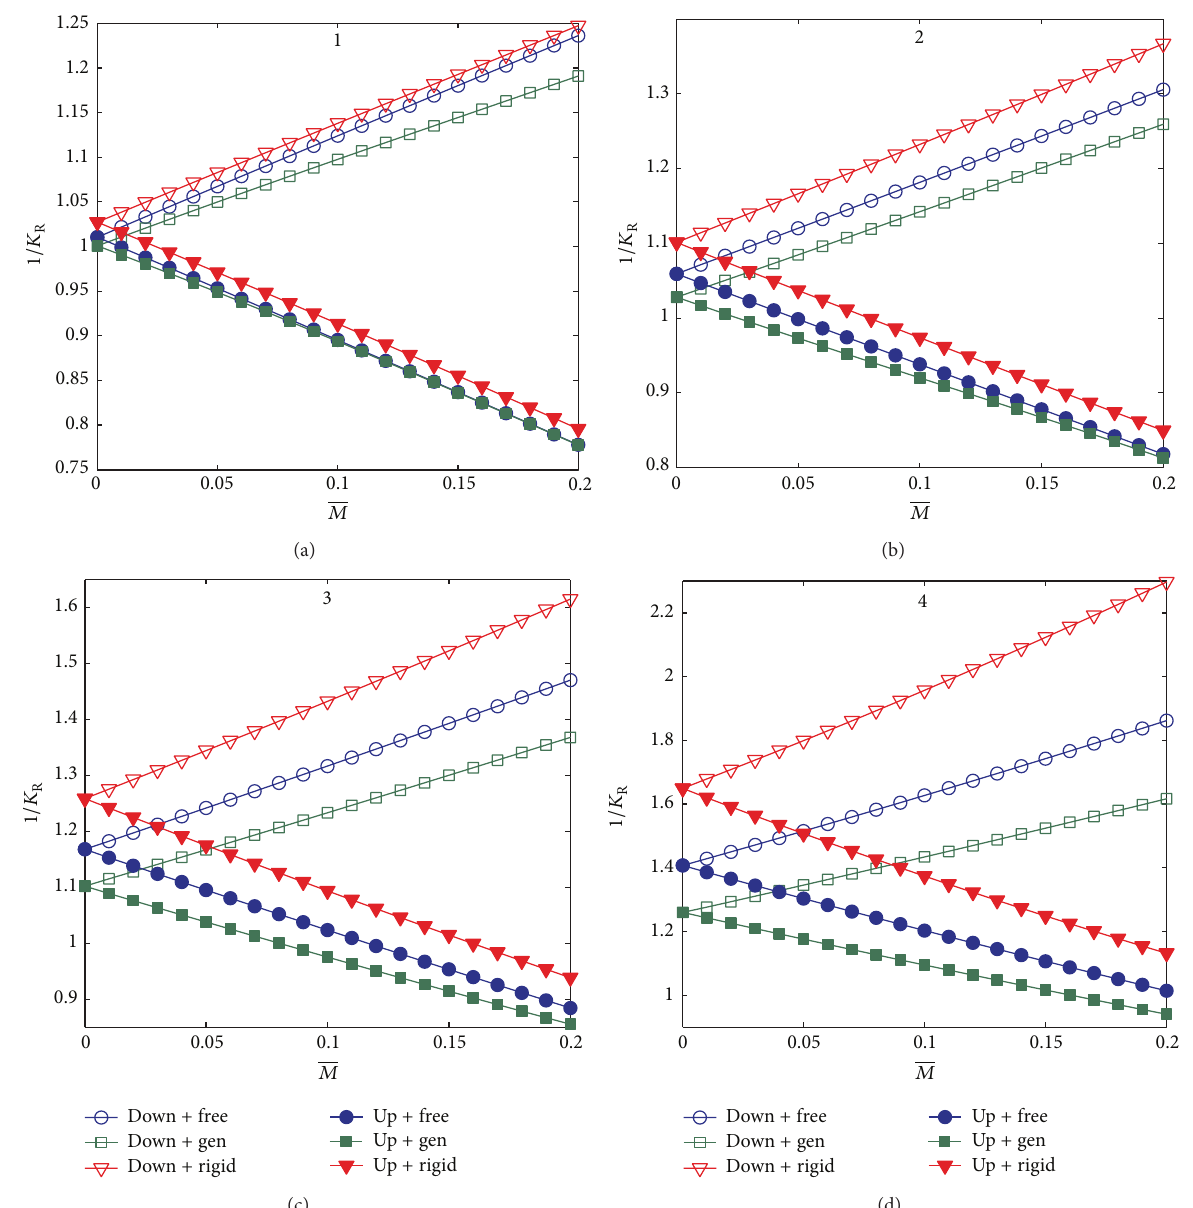
Figure 3: (Color online) Comparison of the relative phase velocity of the first four axisymmetric pseudo-modes with three different types of boundary condition in the turbulent flow. See Figure 2 for legend’s